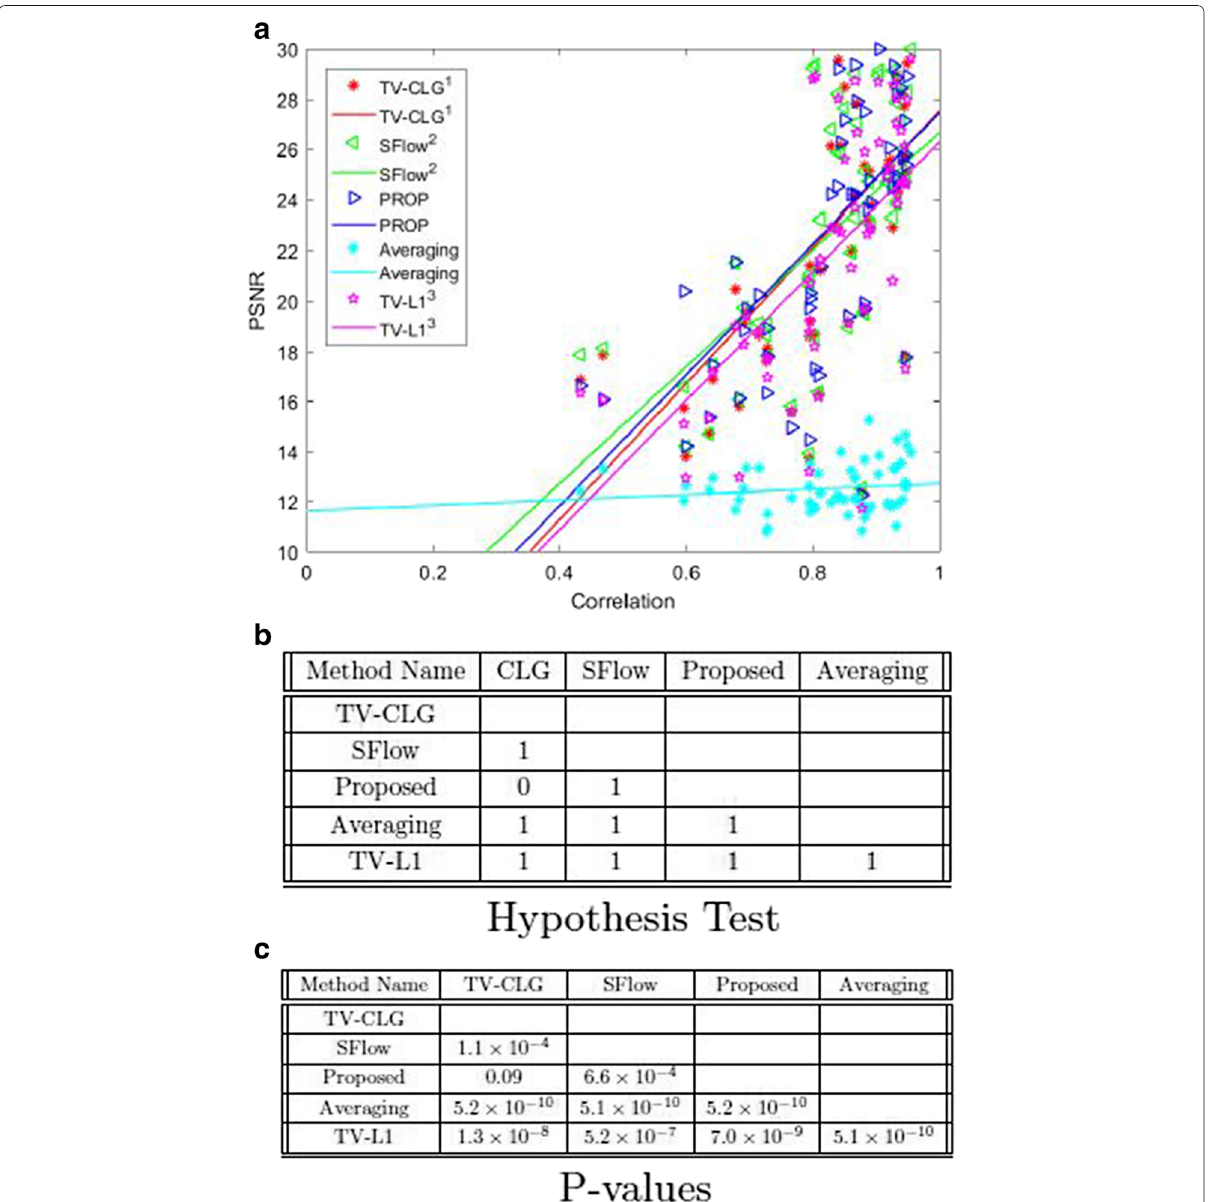
Fig. 5 Comparison of five methods. a The performance of all methods plotted on correlation vs. PSNR axis. As it can be seen from the graph SFlow and frame averaging performs well for large displacement optical flow compared to other methods. The performance of the proposed method tops other methods for correlation > 0.7 which includes majority of the cases. b and c shows Wilcoxon signed rank test for 90% of the